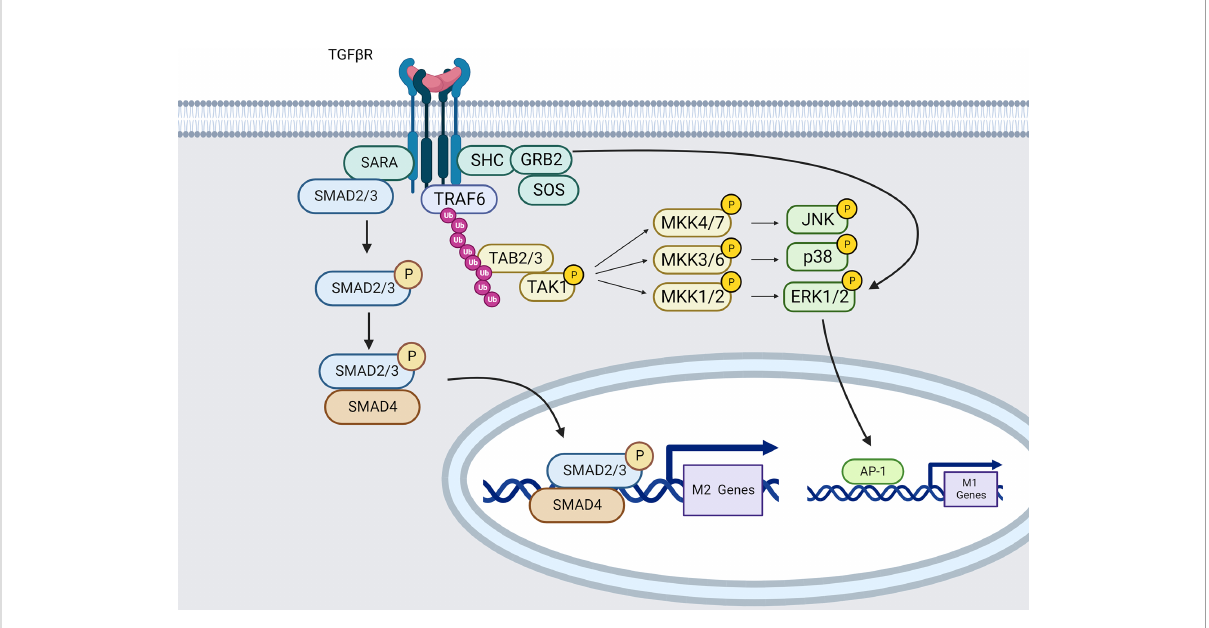
FIGURE 5 TGF b R signaling pathways in macrophages (created using BioRender ®